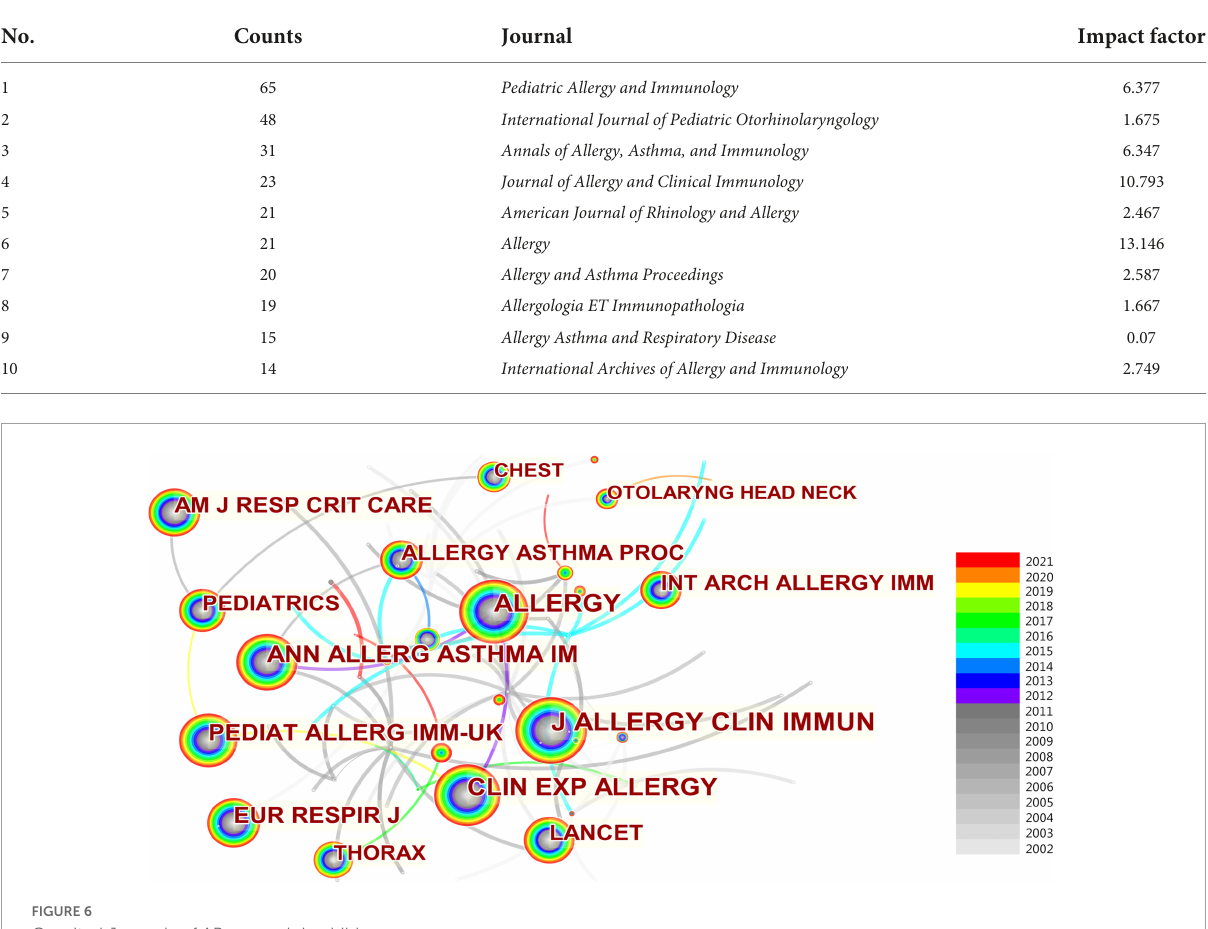
TABLE 4 Top 10 most popular journals in 2002–2021.